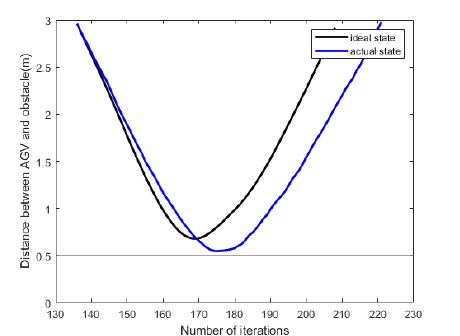
Figure 7. Comparison of distance with obstacles, with and without skidding.